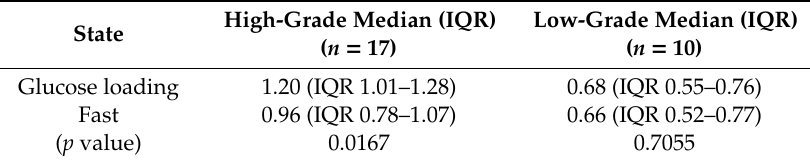
Table 2. The tumor-to-normal brain cortex uptake ratio (TNR) in glioma. Table 2. The tumor ‐ to ‐ normal brain cortex uptake ratio (TNR) in glioma.